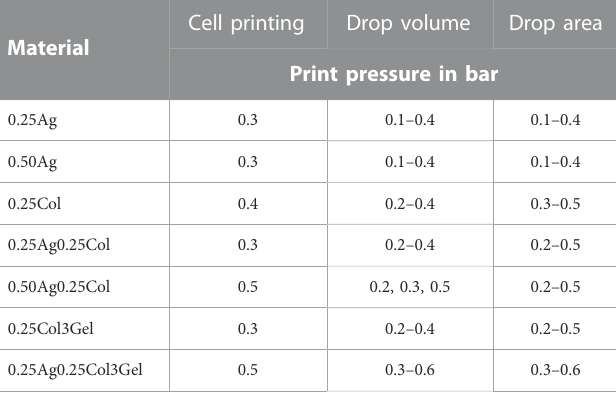
TABLE 2 Print pressure and valve opening time for 3D-bioprinting experiments conducted with all materials, with and without cells.